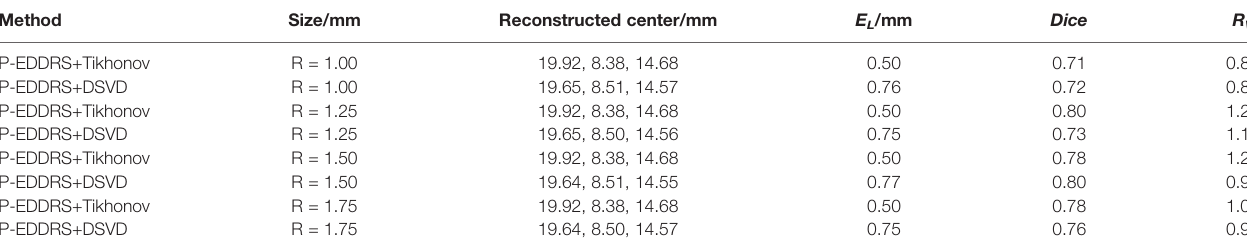
TABLE 4 | Quantitative evaluation results of P-EDDRS framework stability and robustness experiment I.